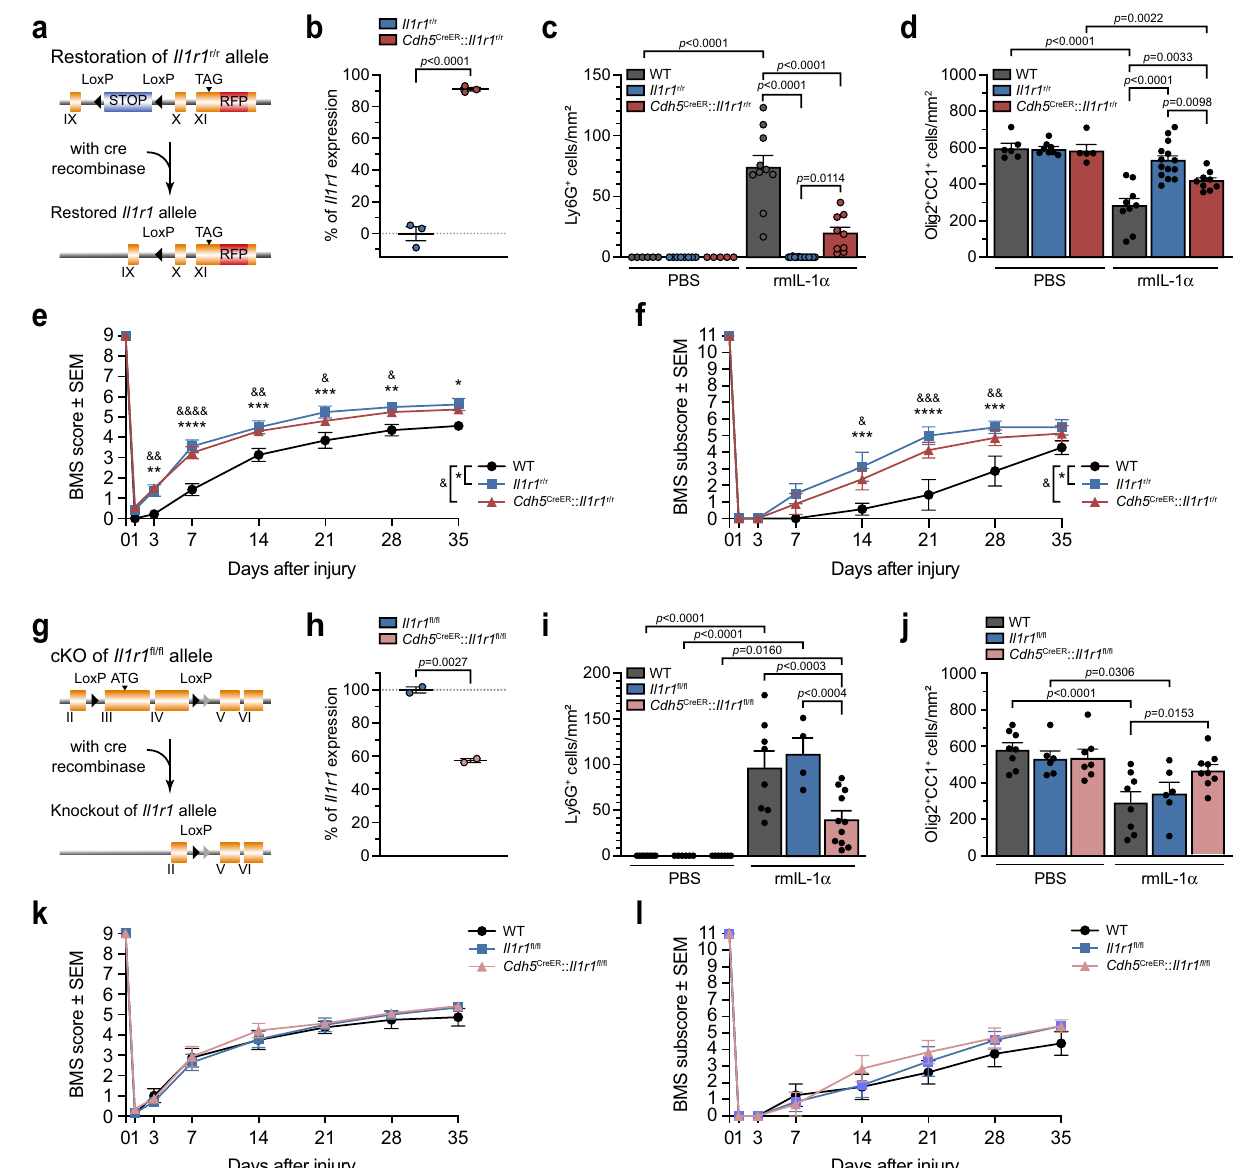
Fig. 7 | IL-1 α -induced neuroin fl ammation and oligodendrocyte loss is partly mediated by endothelial IL-1R1. a Genetic design of the Cdh5 CreER :: Il1r1 r/r mouse line. b Quanti fi cation of Il1r1 gene expression in primary brain endothelial cells isolated from adult Il1r1 r/r mice expressing an IL-1R1-knockout phenotype (set to 0%) and Cdh5 CreER :: Il1r1 r/r mice at 30 days post-tamoxifen treatment ( n =3 mice/ group). c Quanti fi cation of Ly6G + neutrophils in the spinal cord of WT, Il1r1 r/r and Cdh5 CreER :: Il1r1 r/r miceat24hpost-i.c.m.injectionofPBSorrmIL-1 α ( n =6WT+PBS, n =8 Il1r1 r/r +PBS, n =5 Cdh5 CreER :: Il1r1 r/r +PBS, n =10 WT+rmIL-1 α , n =14 Il1r1 r/r + rmIL-1 α , n =9 Cdh5 CreER :: Il1r1 r/r +rmIL-1 α ). d Quanti fi cation of Olig2 + CC1 + mature oligodendrocytes in the spinal cord at 24h post-injection ( n =6 WT+PBS, n =8 Il1r1 r/r +PBS, n =5 Cdh5 CreER :: Il1r1 r/r +PBS, n =9 WT+rmIL-1 α , n =14 Il1r1 r/r +rmIL-1 α , n =9 Cdh5 CreER :: Il1r1 r/r +rmIL-1 α ). e , f Locomotor function was assessed using the BMS score ( e ) and BMS subscore ( f ) after SCI ( n =8 mice/group). g Genetic design of the Cdh5 CreER :: Il1r1 fl / fl mouse line. h Il1r1 gene expressioninbrain